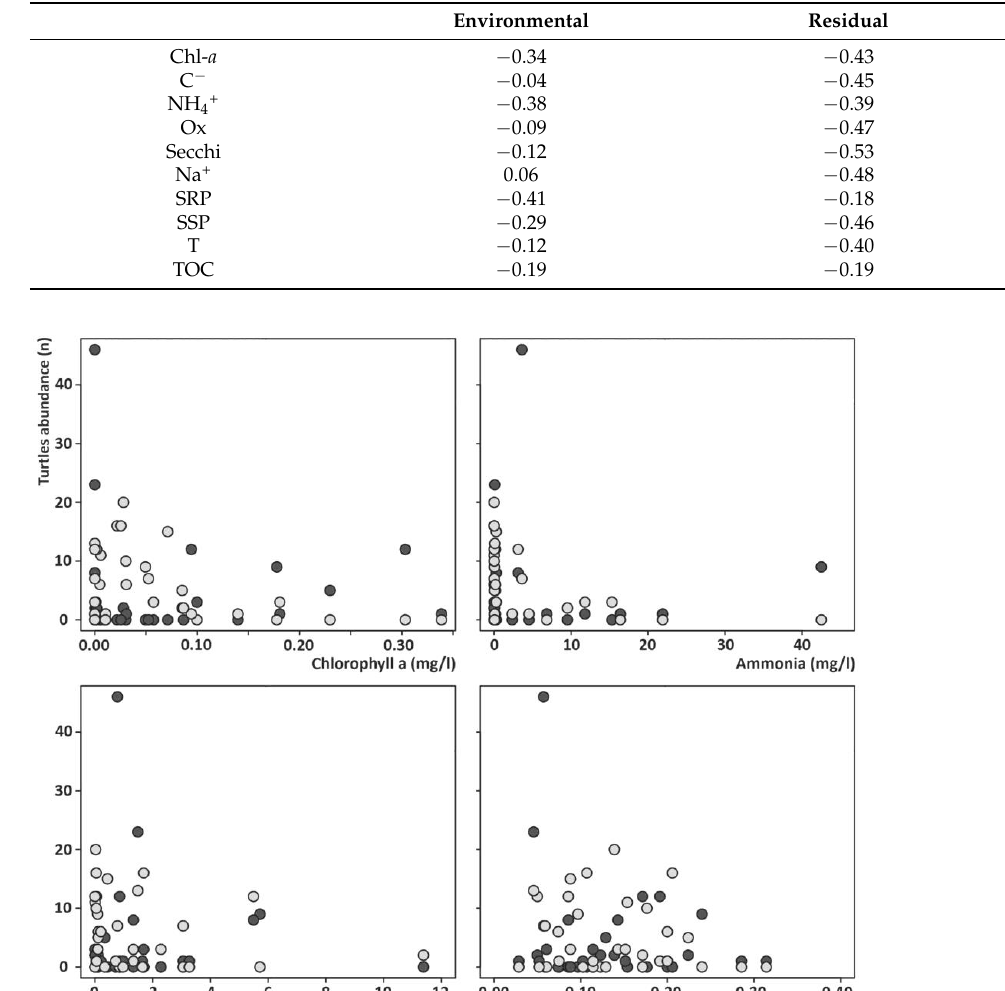
Table 4. Results from latent variable models (LVM). We show two types of correlation. The first (Environmental) is the correlation between the fitted values of the two species [122], representing the correlation between species that can be attributed to a shared/diverging environmental response. The second type of correlation (Residual) was calculated using the latent variable coefficients, also known as factor loadings. It represents the correlation between species that may be attributable to biotic interactions or missing environmental covariates.